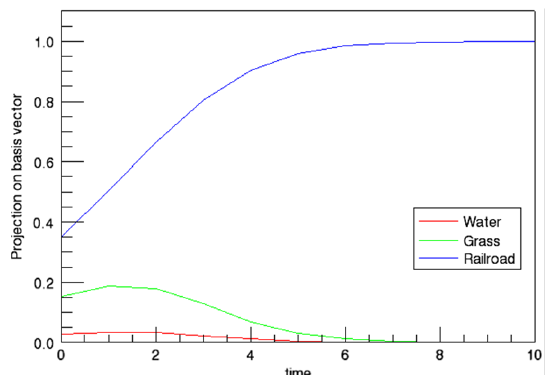
Figure 3: Simulation of the synergetics process for the test vector in Fig. 2, and related to the same prototype vectors. At t = 0 the test vector is projected into the space spanned by the three prototype vectors. The test vector is then attracted by one stable final state, corresponding to one of the basis vectors, which is selected as the